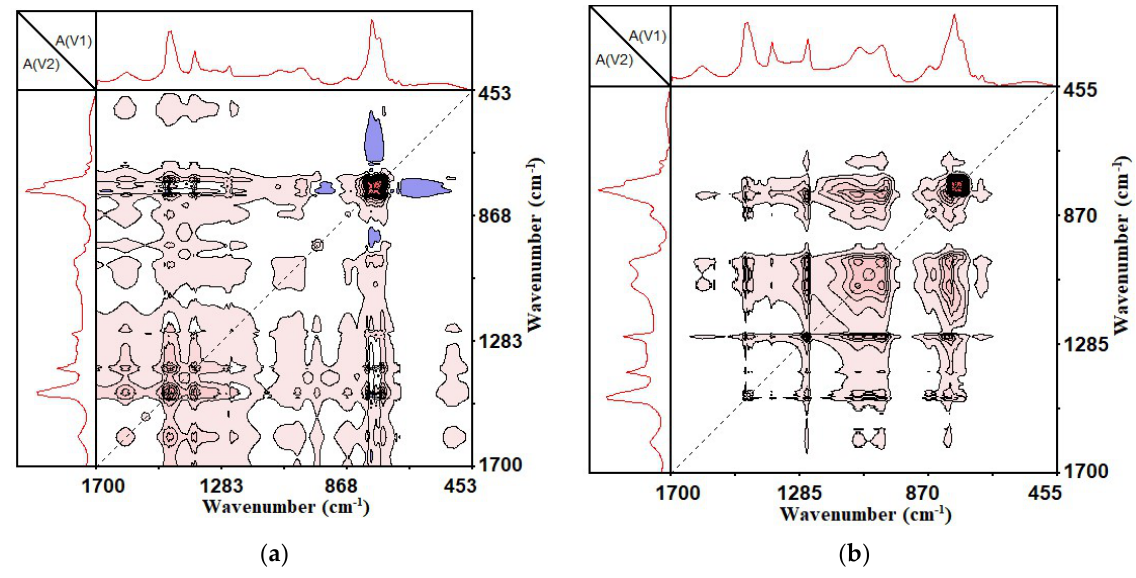
Figure 6. Two-dimensional synchronous infrared correlation spectrum of 1700~450 cm −1 . ( a ) SBS-modified asphalt binder; ( b ) SBS + 1% CNTs composite-modified asphalt binder.